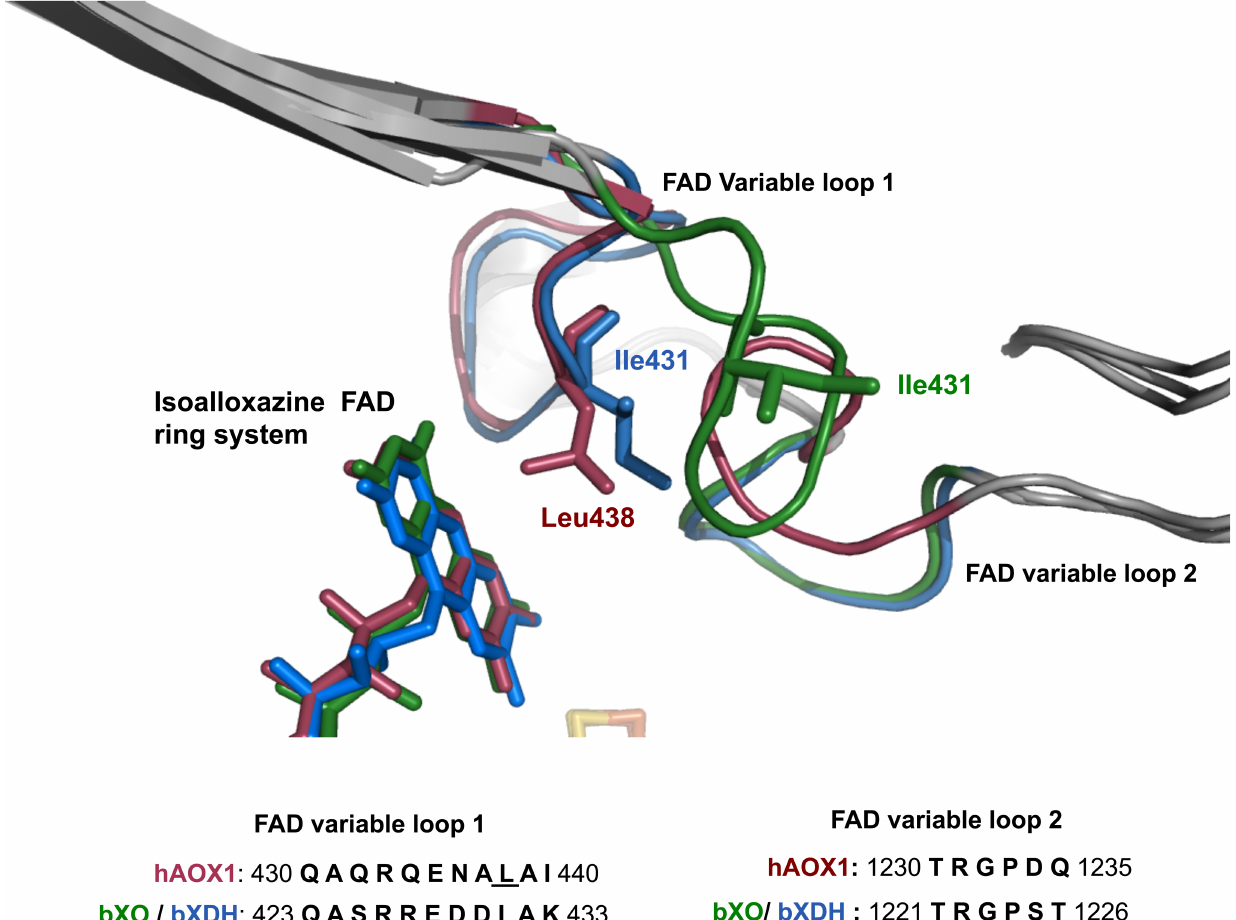
Fig 7. The FAD site of hAOX1. Close-upand superpositionof the crystal structures of the FAD bindingsites of hAOX1 (red, PDB ID: 4UHW), bXO (green, PDB ID: 1FIQ) and bXDH (blue, PDB ID: 1FO4). Shownis the location of the residues Leu438of hAOX1 (dark red) and Ile431 of bXO/bXDH (green/blue). The FAD variableloops 1 and 2 are located in close proximity to the isoalloxazine ring of the FAD cofactors. The amino acid sequencealignmentof the two loops is shown.